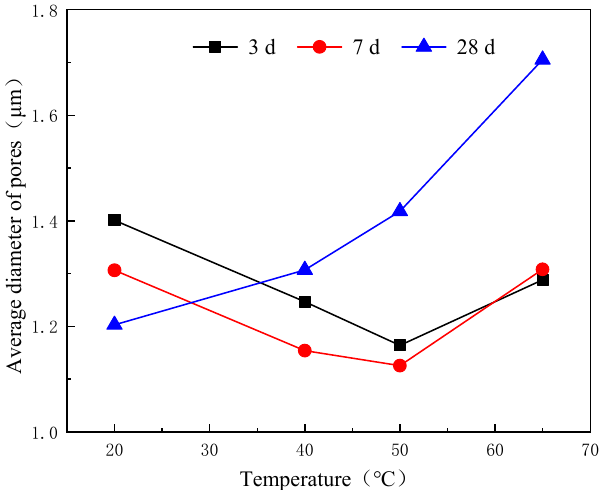
Figure 14. Variation law of porosity of CPB under different curing temperatures.